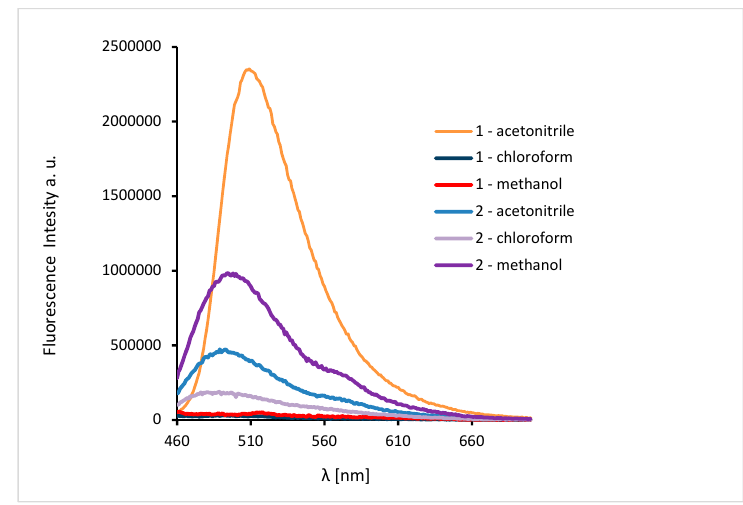
Figure 11. Solution emission spectra of complexes. ( λ ex = 450 nm, MeCN, chloroform and methanol 1 × 10 − 4 mol / dm 3 , RT).